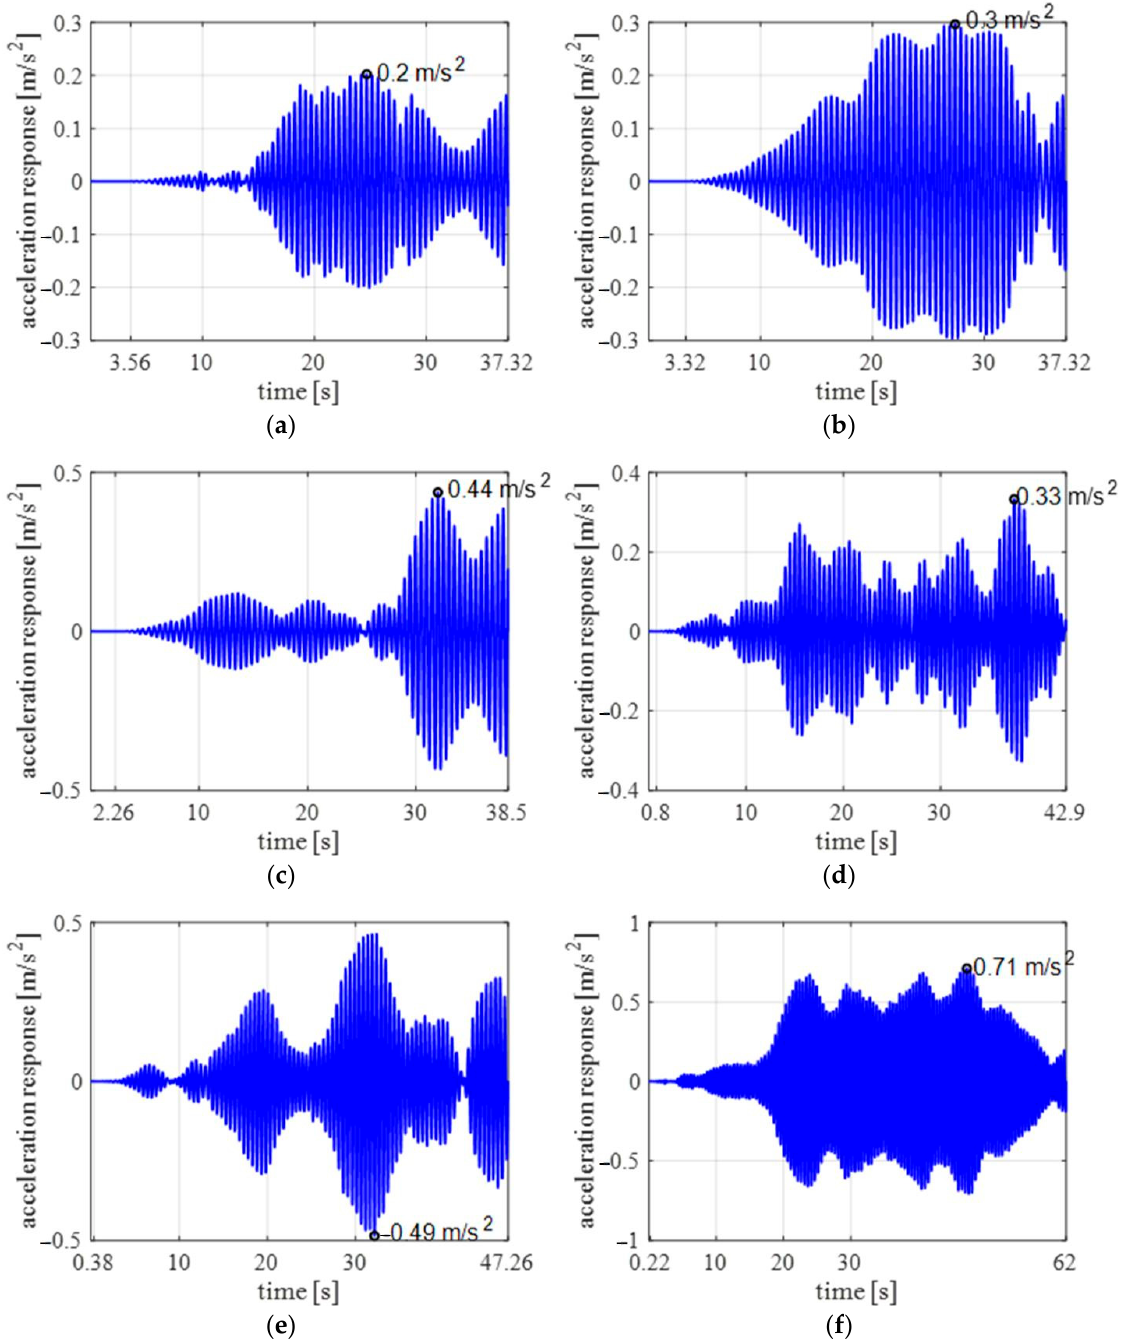
Figure 10. The time history of crowd-induced vibrations at the midspan of the structure in the vertical (Z) direction for different pedestrian densities. ( a ) 0.1 pedestrians/m 2 , ( b ) 0.2 pedestrians/m 2 , ( c ) 0.5 pedestrians/m 2 , ( d ) 0.8 pedestrians/m 2 , ( e ) 1.0 pedestrians/m 2 , ( f ) 1.5 pedestrians/m 2 .